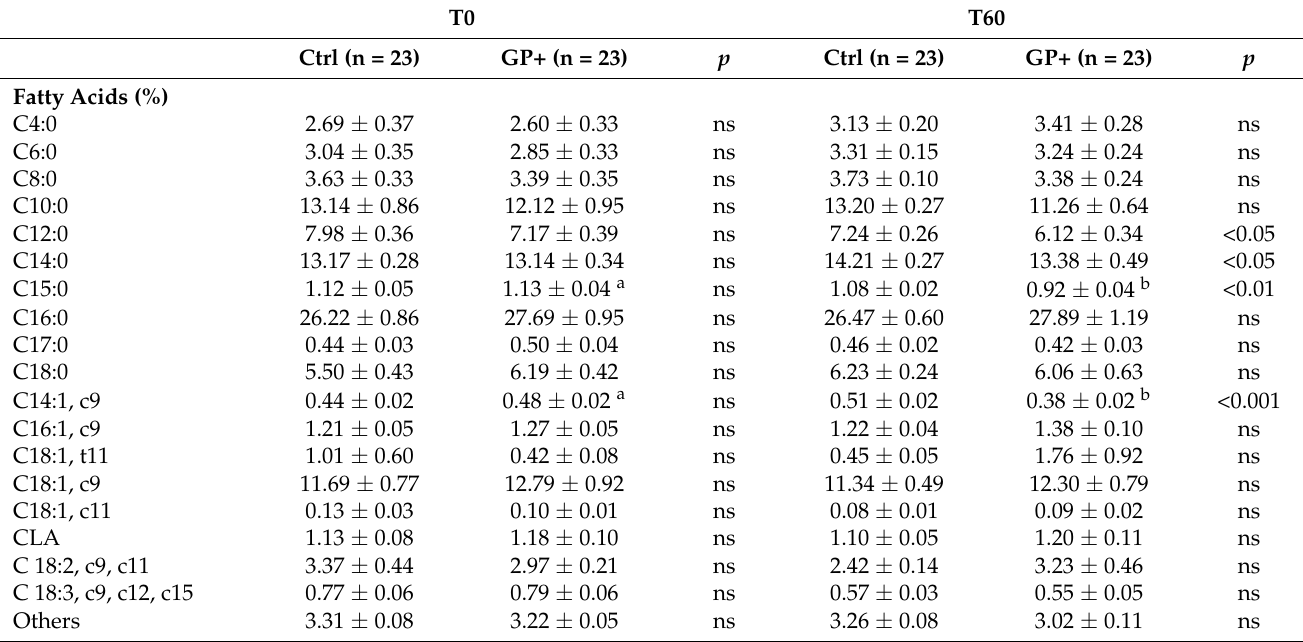
Table 5. Fatty acid profile at the beginning (T0) and after 60 (T60) days of trial in raw milk samples obtained from ewes fed a standard diet (Ctrl) and grape pomace diet